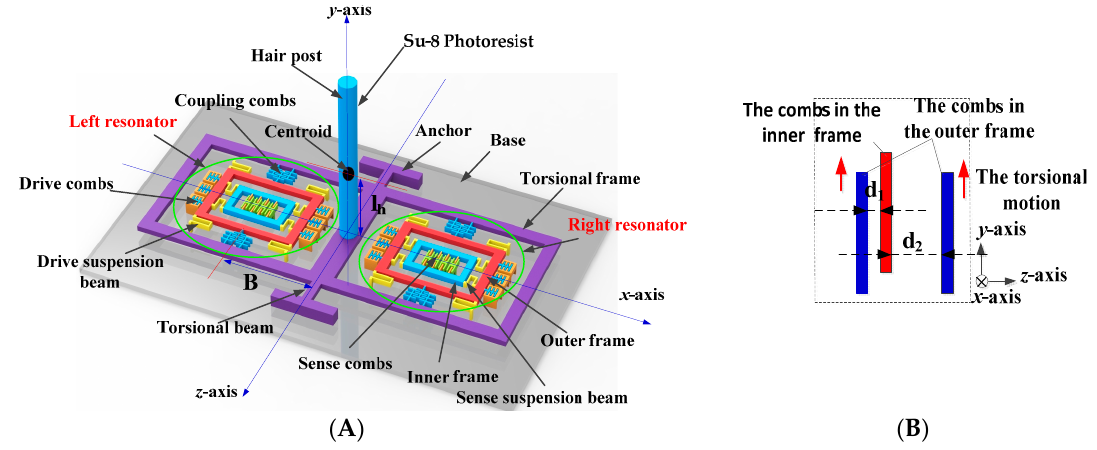
Figure 1. The structure scheme of hair sensor. ( A ) The whole structure; ( B ) The coupling combs.